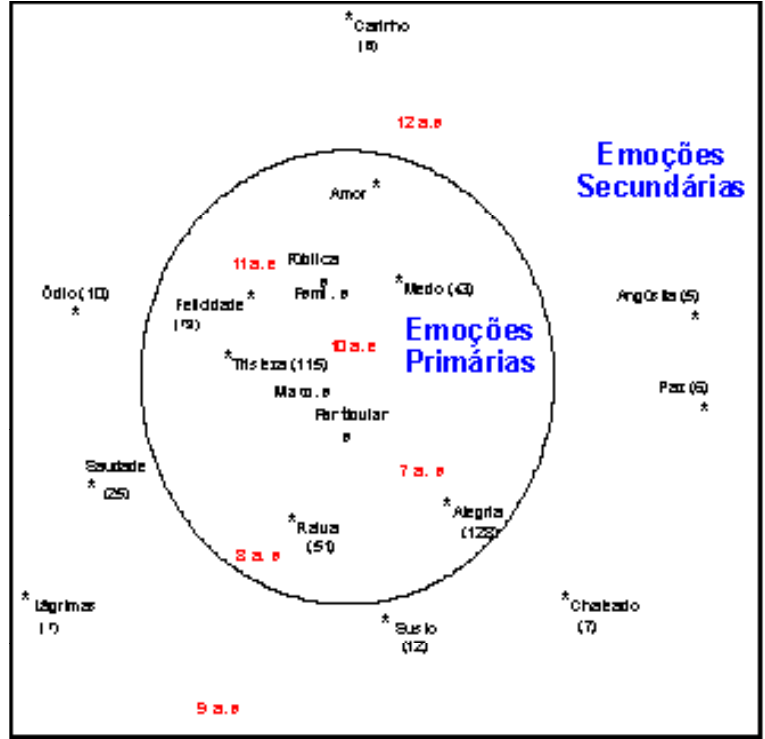
Figura 1. Análise SSA das emoções produzidas na Associação Livre considerando como variáveis externas (e) o tipo de escola, o sexo e a faixa etária. Nota. Projeção tridimensional, Coordenada 1 x 2, Coeficiente de Alienação 0,12. Freqüência (em